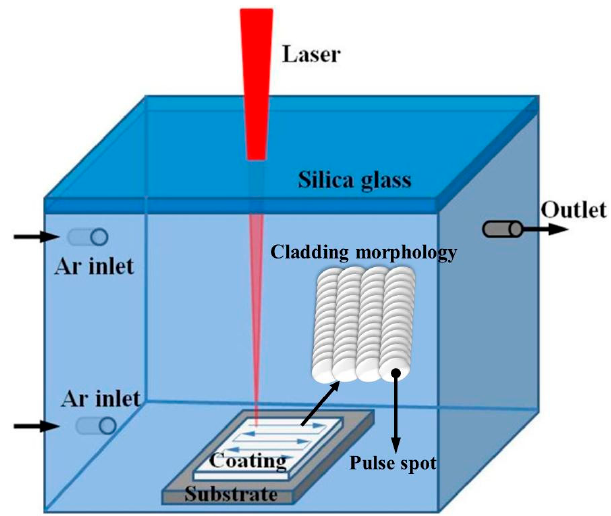
Figure 2. Schematic diagram of the protective box in the laser cladding (LC).